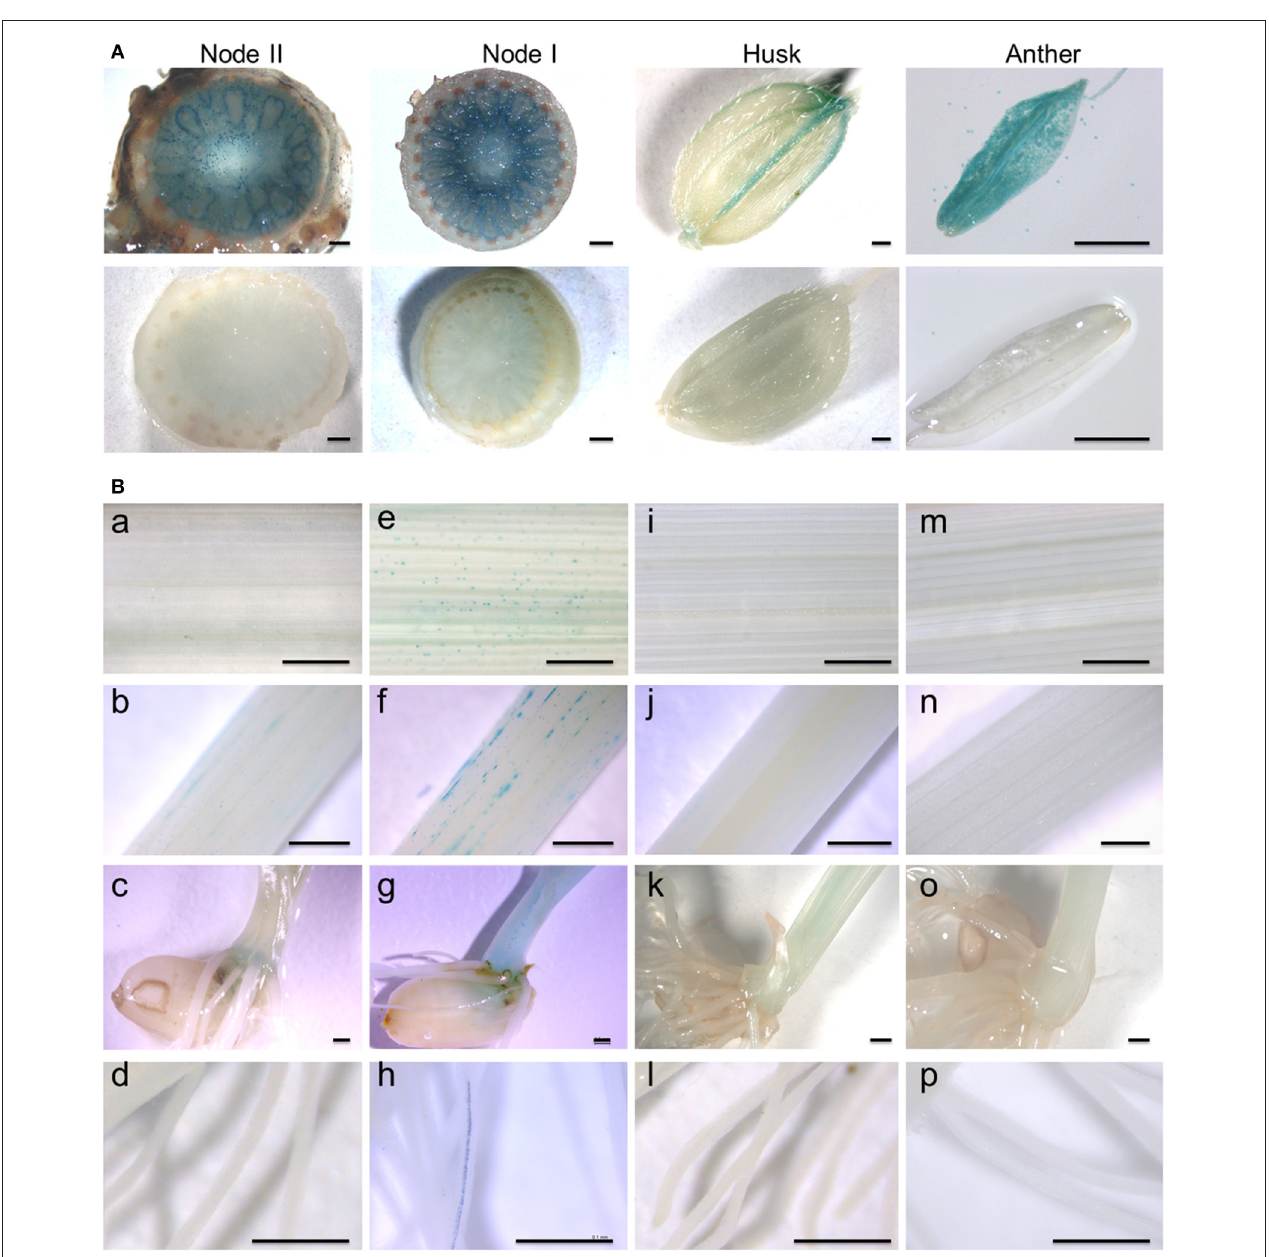
FIGURE 2 | Spatial and temporal expression of the OsARM1 pro ::GUS construct. (A) Histochemical GUS staining of transgenic rice expressing OsARM1 pro ::GUS showing high levels of GUS signal in the enlarged vascular bundles of node I and node II, the vessel tissues of the husk, and the anther (upper images). GUS staining of wild-type SSBM was used as a negative control (bottom images). (B) The expression patterns of OsARM1 pro ::GUS upon exposure to As(III). Various organs were collected from two-week-old seedlings at the vegetative growth stage. The OsARM1 pro ::GUS seedlings were treated with 50 µ M As(III), and the samples were harvested at 0 and 6h after treatment. Images in (e–h) show As(III)-treated samples of leaves (e), stems (f), basal regions (g), and roots (h) of OsARM1 pro ::GUS seedlings. Images in (a–d) show the corresponding untreated controls. Wild-type SSBM samples harvested from As(III)-treated (m–p) or untreated (i–l) plants were used as negative controls. Bars = 500 µ